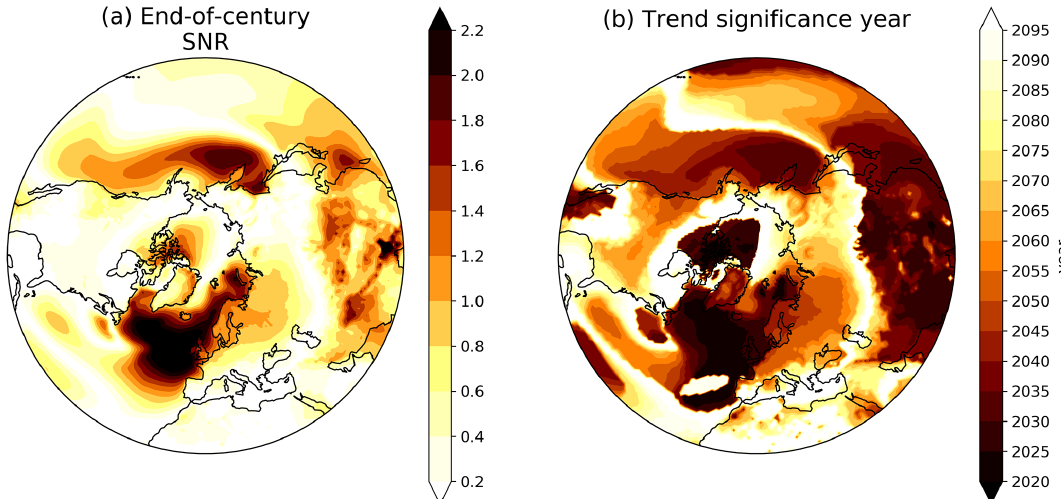
Figure 2. Significance of the DJF near-surface air temperature response under geoengineering. (a) The signal-to-noise ratio of the end- of-century ensemble mean response in GEO8.5 (2075–2095) relative to Base (2010–2030). (b) The endpoint year in which the GEO8.5 ensemble mean trends beginning in 2020 become statistically significant from zero, and remain significant, at the 95% confidence level.